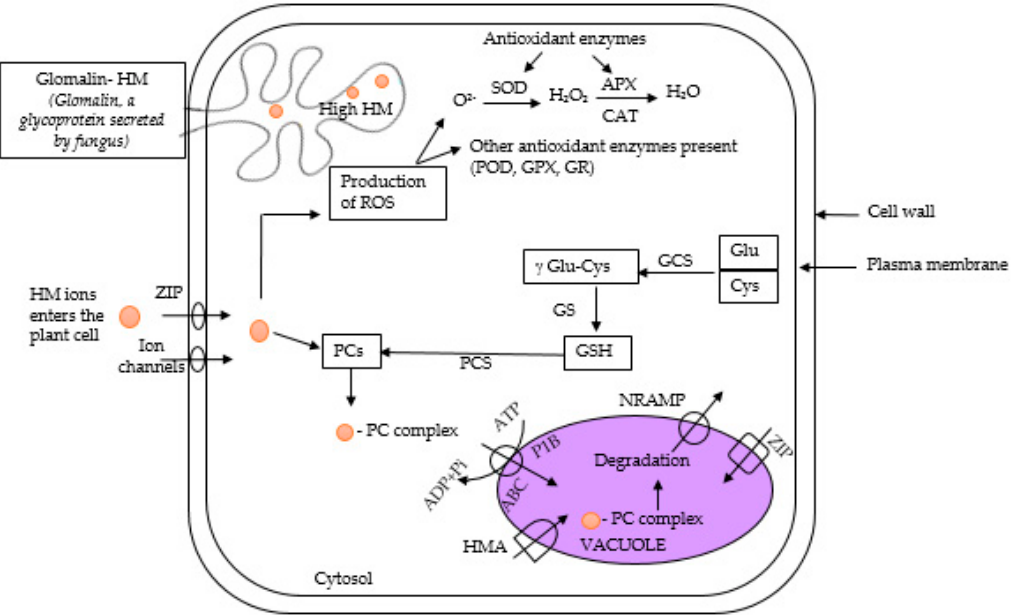
Figure 5. Mitigation of heavy metal (HM) stress by chelating agents. The figure shows the uptake of HM that is mediated via zinc and iron like protein (ZIP) transporter and other ion channels; HM ions, when entering the cytosol, activate the enzyme phytochelatin synthase (PCS) and catalyze the formation of phytochelatins (PCs) from glutathione (GSH), which is synthesized from glutamate (Glu) and cysteine (Cys) by the transfer of γ glutamyl-cysteinyl ( γ Glu-Cys) conjugates onto GSH via glutathione synthetase (GS); PCs binds with the cytosolic HM ions and form heavy metal–phytochelatin (HM-PC) complexes, which enter the vacuole via ATP-binding-cassette (ABC), P1B ATPase (P1B) and other transporters such as heavy metal ATPases (HMA), natural resistance-associated macrophage protein (NRAMP) and ZIP transporters. HM ions also lead to the production of reactive oxygen species (ROS) such as superoxide radical (O 2 − ), which is dismutated by superoxide dismutase (SOD) and produces hydrogen peroxide (H 2 O 2 ), which is further broken down into water (H 2 O) by ascorbate peroxidase (APX) and catalase (CAT). Peroxidase (POD); glutathione peroxidase (GPX); glutathione reductase (GR).